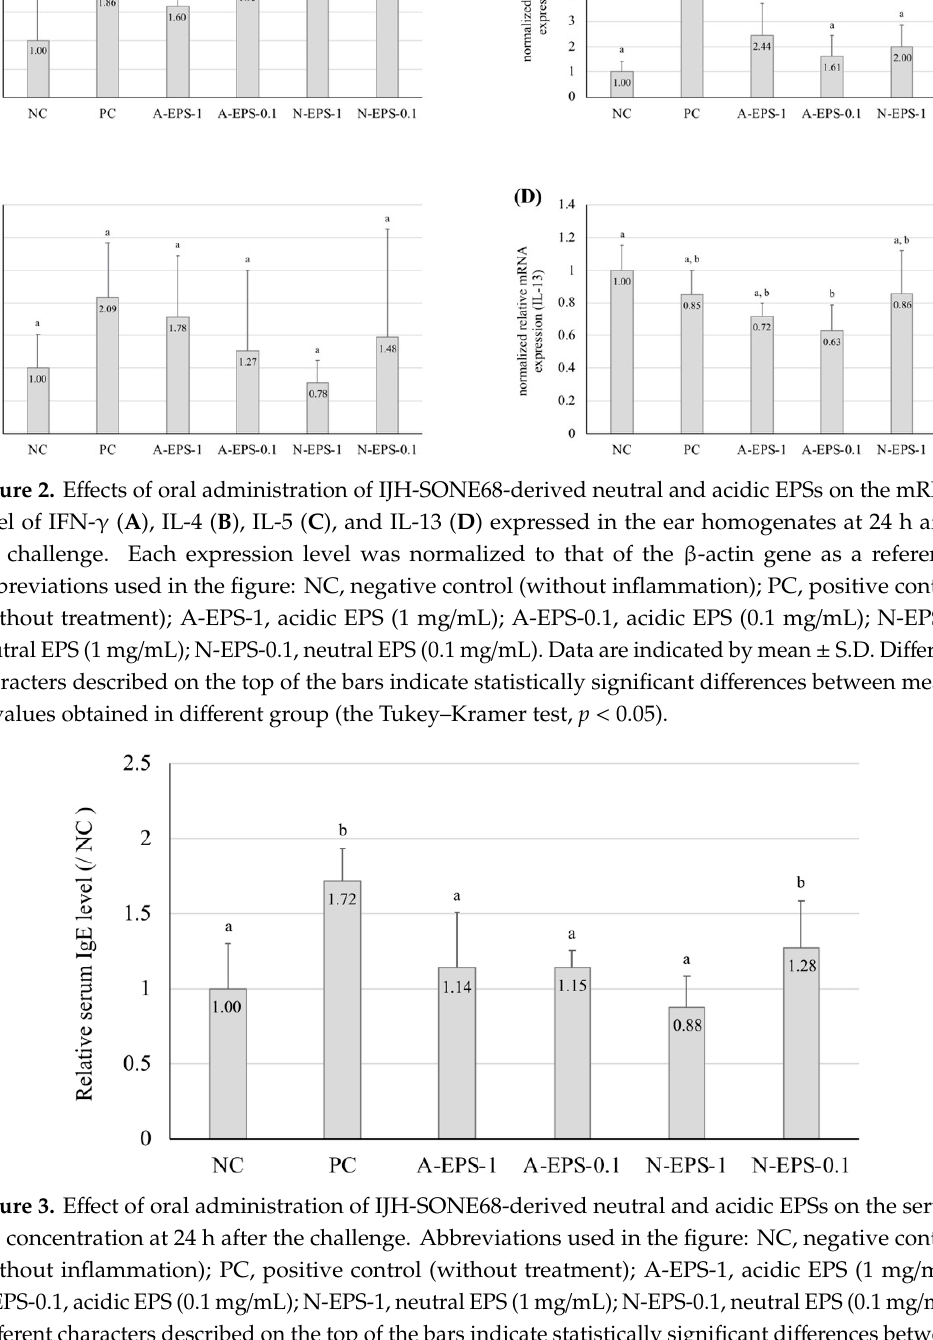
Figure 2. Effects of oral administration of IJH-SONE68-derived neutral and acidic EPSs on the mRNA level of IFN- γ ( A ), IL-4 ( B ), IL-5 ( C ), and IL-13 ( D ) expressed in the ear homogenates at 24 h after the challenge. Each expression level was normalized to that of the β -actin gene as a reference. Abbreviations used in the figure: NC, negative control (without inflammation); PC, positive control (without treatment); A-EPS-1, acidic EPS (1 mg/mL); A-EPS-0.1, acidic EPS (0.1 mg/mL); N-EPS-1, neutral EPS (1 mg/mL); N-EPS-0.1, neutral EPS (0.1 mg/mL). Data are indicated by mean ± S.D.